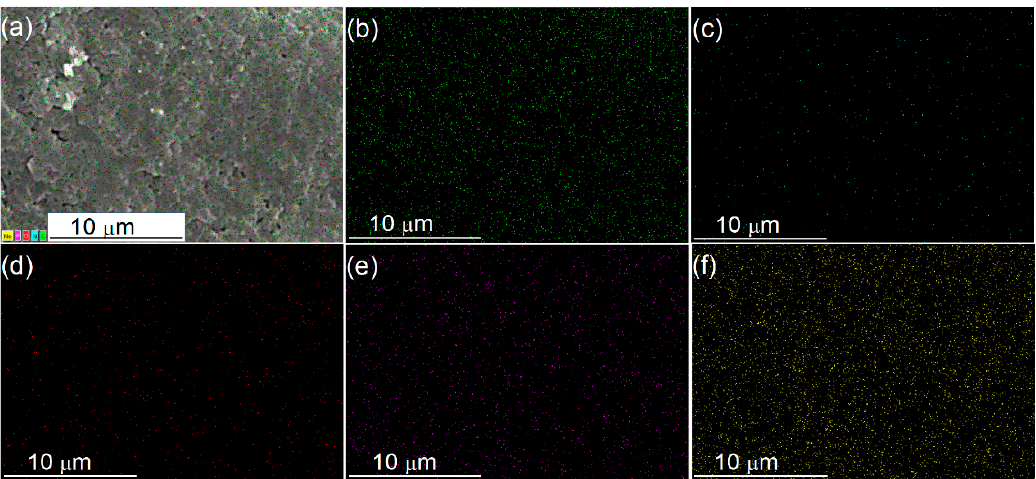
Figure 2. SEM / EDX-mapping of the 40 -PMo 12 / PAN catalyst. ( a ) SEM photo, ( b ) C element, ( c ) N Figure 2. SEM/EDX-mapping of the 40 -PMo 12 /PAN catalyst. ( a ) SEM photo, ( b ) C element, ( c ) N element, ( d ) O element, ( e ) P element, and ( f ) Mo element, ( d ) O element, ( e ) P element, and ( f ) Mo element.